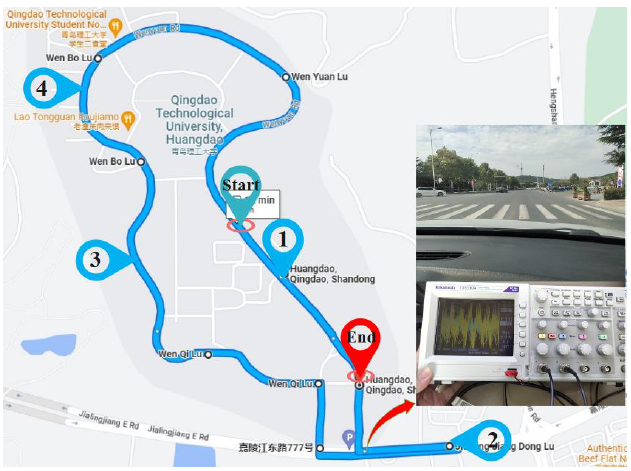
Figure 10. Test route plan for the test vehicle.